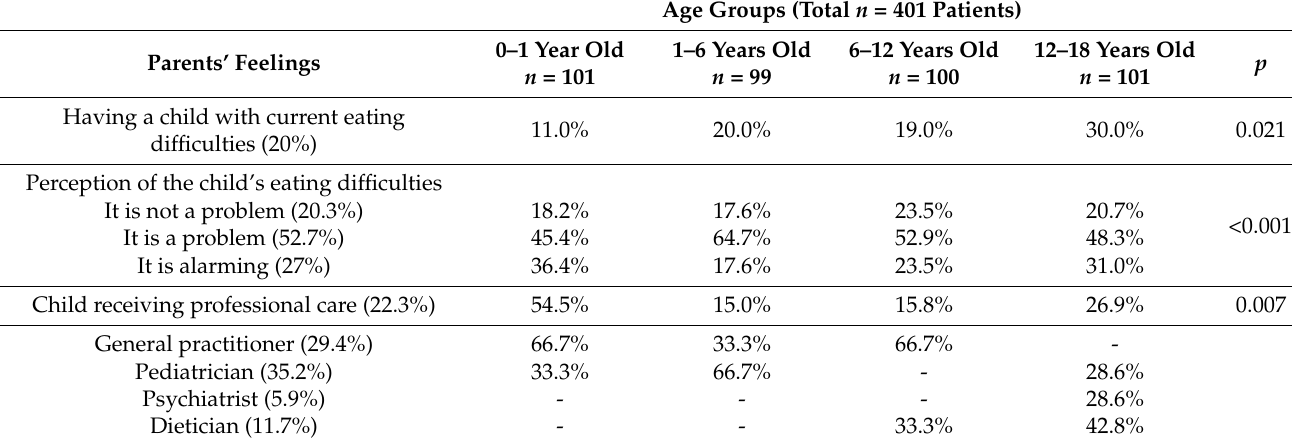
Table 4. Parents’ feelings about their child’s current eating difficulties, and the care